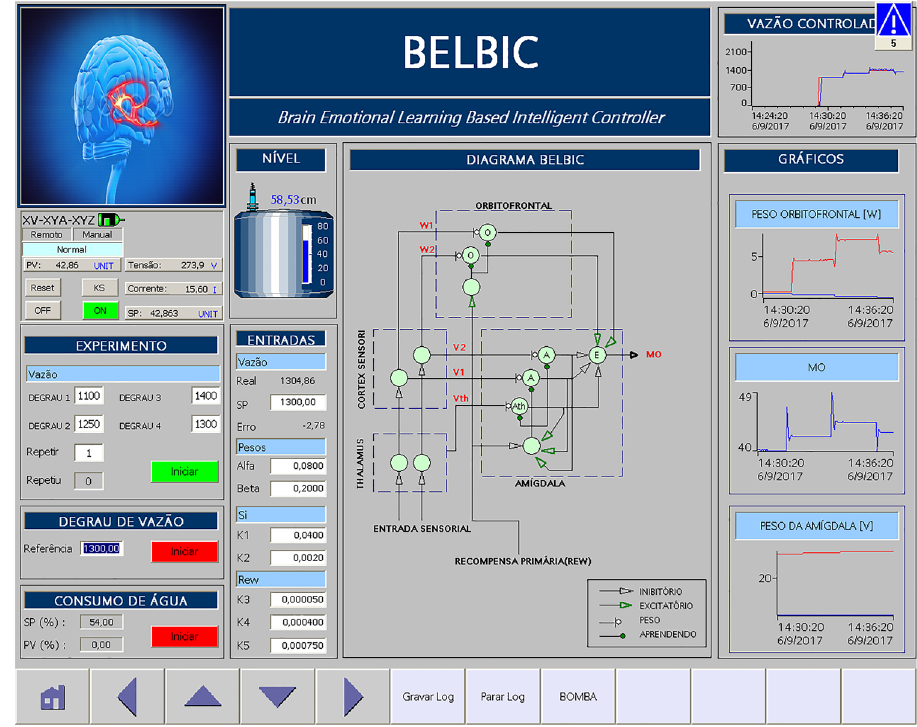
Figure 15. BELBIC controller supervisory screen in WinCC.